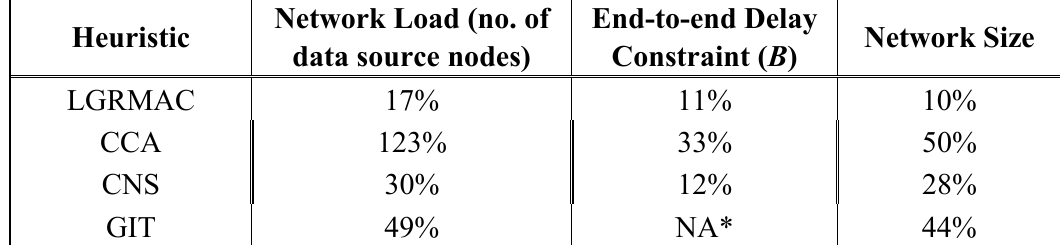
Table 1. Performance comparison between LGR and the other three